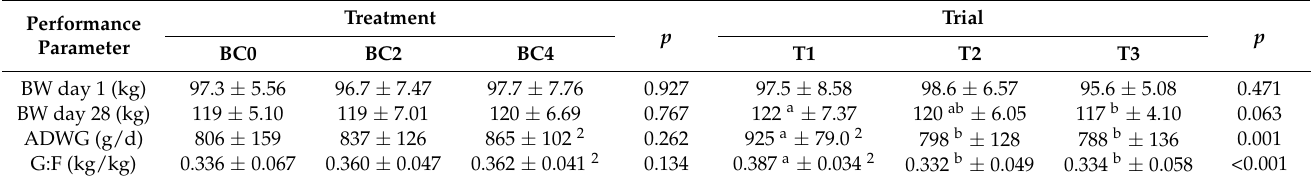
Table 4. Bodyweight (BW, mean ± SD), average daily weight gain (ADWG, mean ± SD), gain-to-feed-ratio 1 (G:F, mean ± SD) in dependence on treatment (BC0, BC2, BC4) and trial (T1, T2, T3). Performance